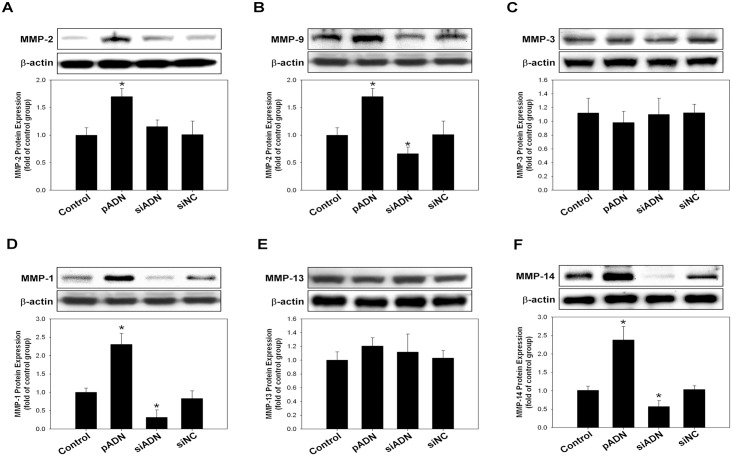
Overexpression or silencing of adiponectin expression on the matrix metalloproteinase (MMP) activity of A549 cells.Gelatin zymography was used to analyzed the activities of MMP-2/MMP-9, MMP-1/MMP-3, and MMP-13/MMP-14. (A–F) The activities of MMP-9, -1, and -14 were increased after the overexpression of adiponectin and decreased with the silencing of adiponectin. Expression of MMP-3 and -13 did not change regardless of adiponectin augmentation or silencing.